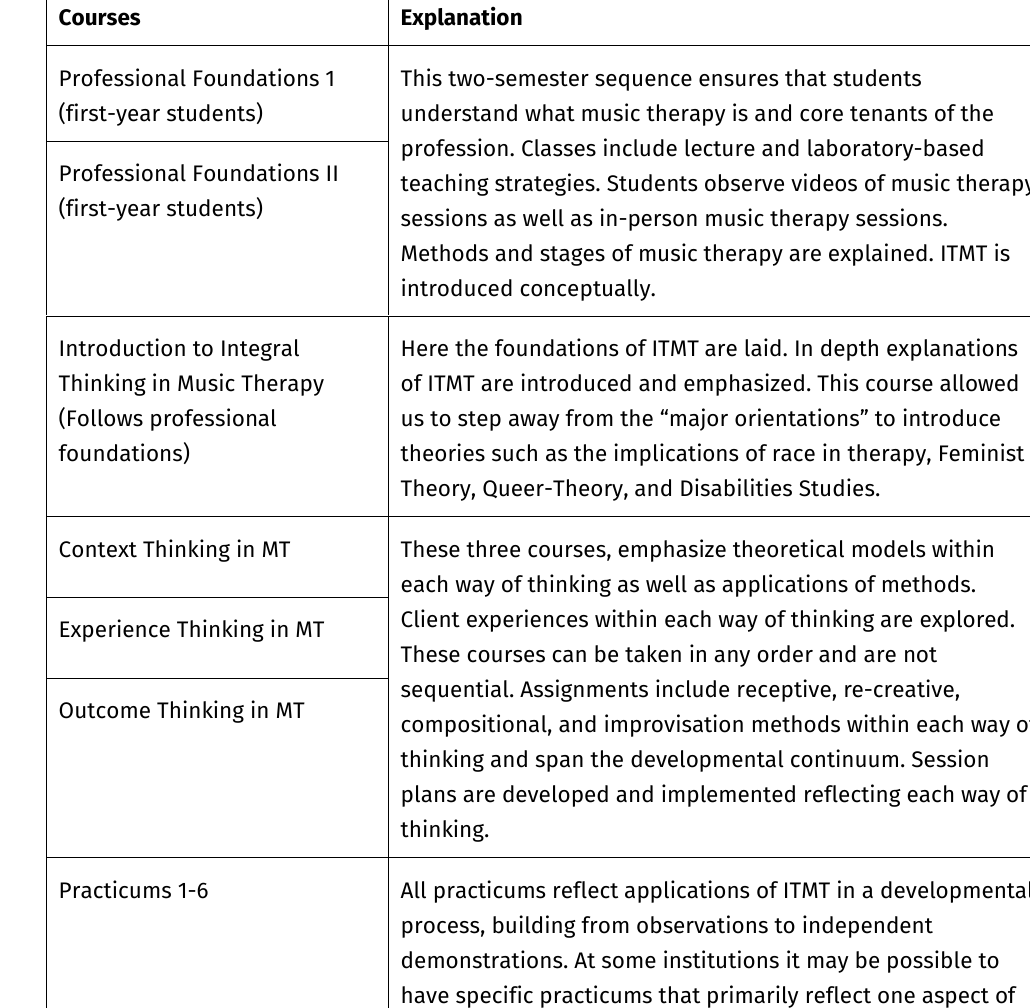
Table 1. Curriculum